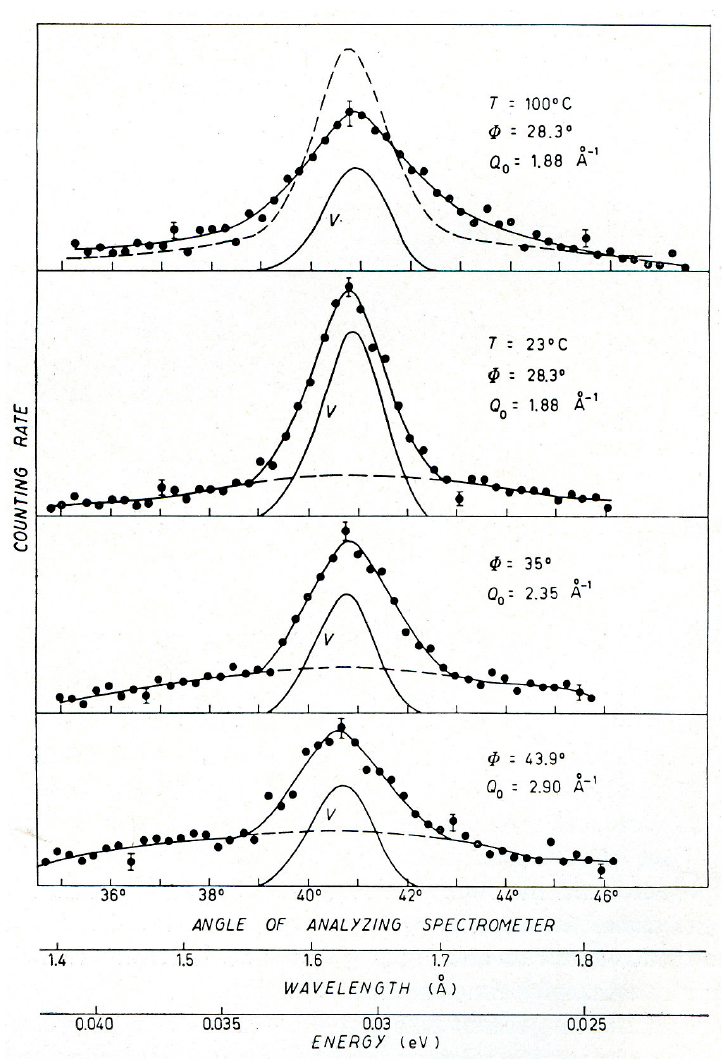
Figure 13. Measured energy distributions of 1.62 Å neutrons scattered by specimens of water, H 2 O, at room temperature for wavevectors , Q, near the maximum in S(Q). The results are plotted as a function of the angle 2 θ A , of the analyzing spectrometer, the scattered neutron wavelength, and its energy. The resolution function as measured with vanadium is shown. The results indicate the separation of the quasi-elastic scattering from the inelastic scattering. The latter is consistent with the scattering from a gas of H 2 O molecules in this region of Q. This figure is taken from Figure 4 of ref. [46] courtesy of Nuovo Cimento.